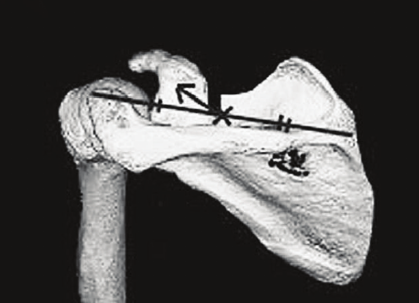
Figure 13: Anatomic representation of the Matsumoto technique (Matsumoto et al. [5]). (Reprinted with permission from Elsevier.)